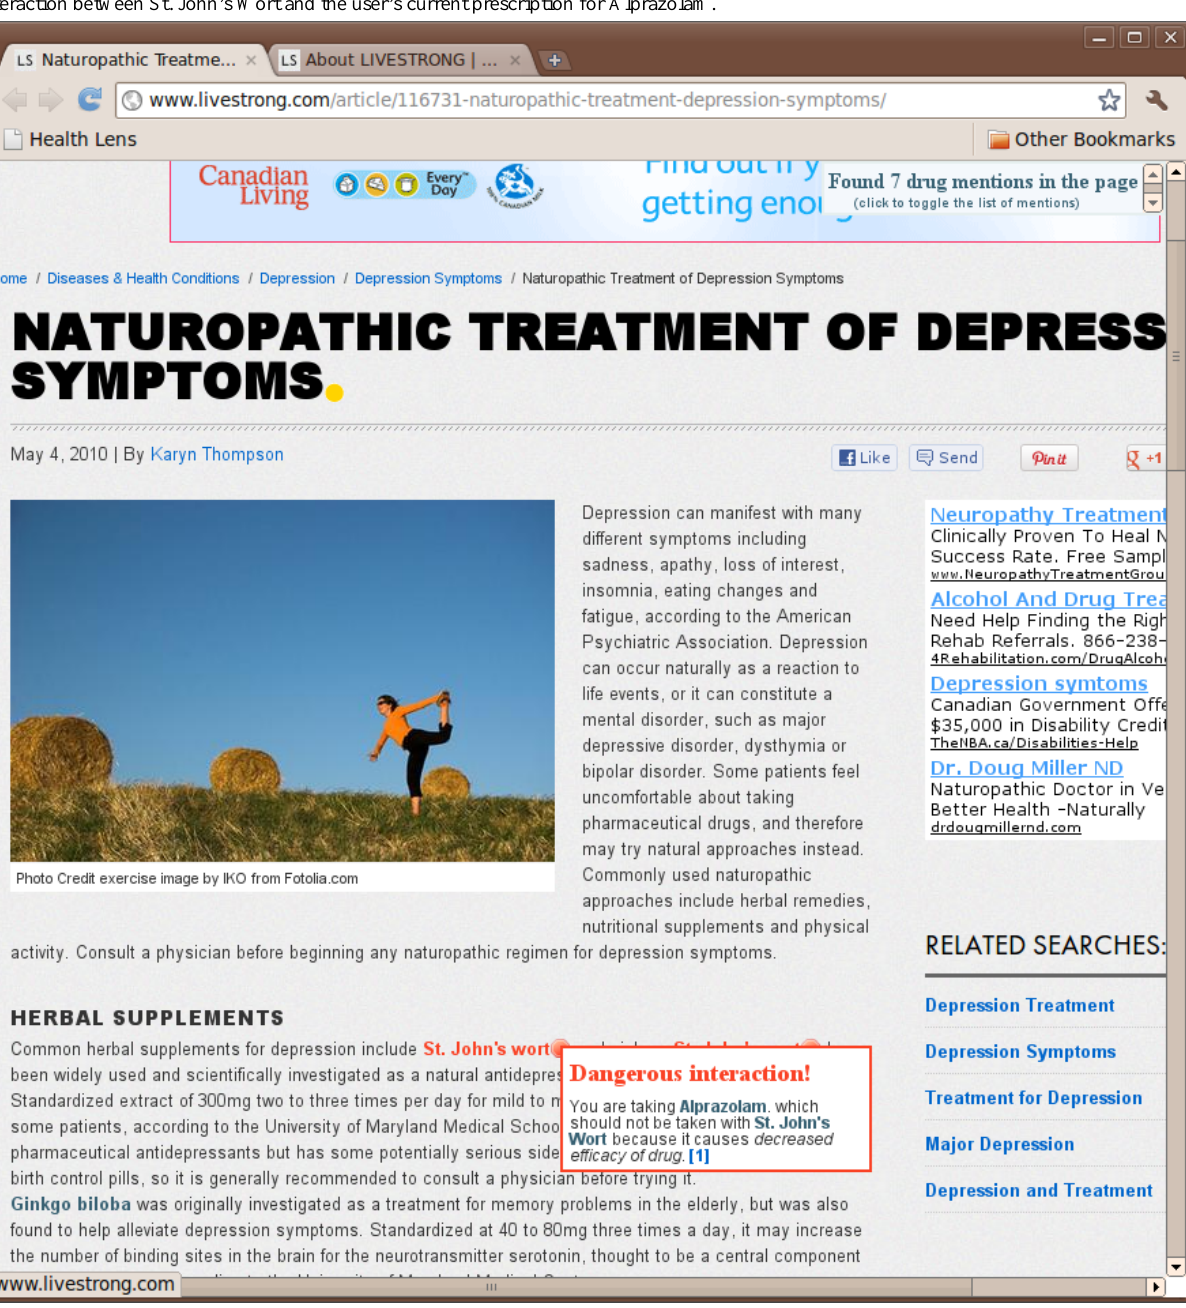
Figure 3. A screenshot of the Health Lens bookmarklet operating on a real webpage. The subject page correctly advises its readers to consult a physician before taking St. John’s Wort and mentions a possible interaction with birth control pills. Health Lens augments this information with a warning